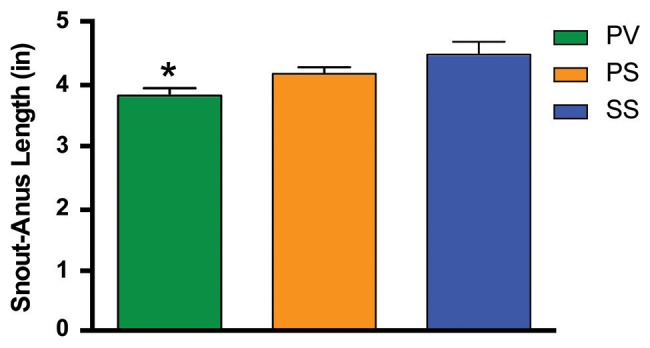
Bar graph showing the effect of bilateral subdiaphragmatic vagotomy + pyloroplasty on snout-to-anus length in not yet fully obese Mc4r−/− (n = 6–8 per treatment group) fed a normal diet. *p < 0.05 criterion for statistical significance using a one-way ANOVA and Tukey post-hoc comparison test.